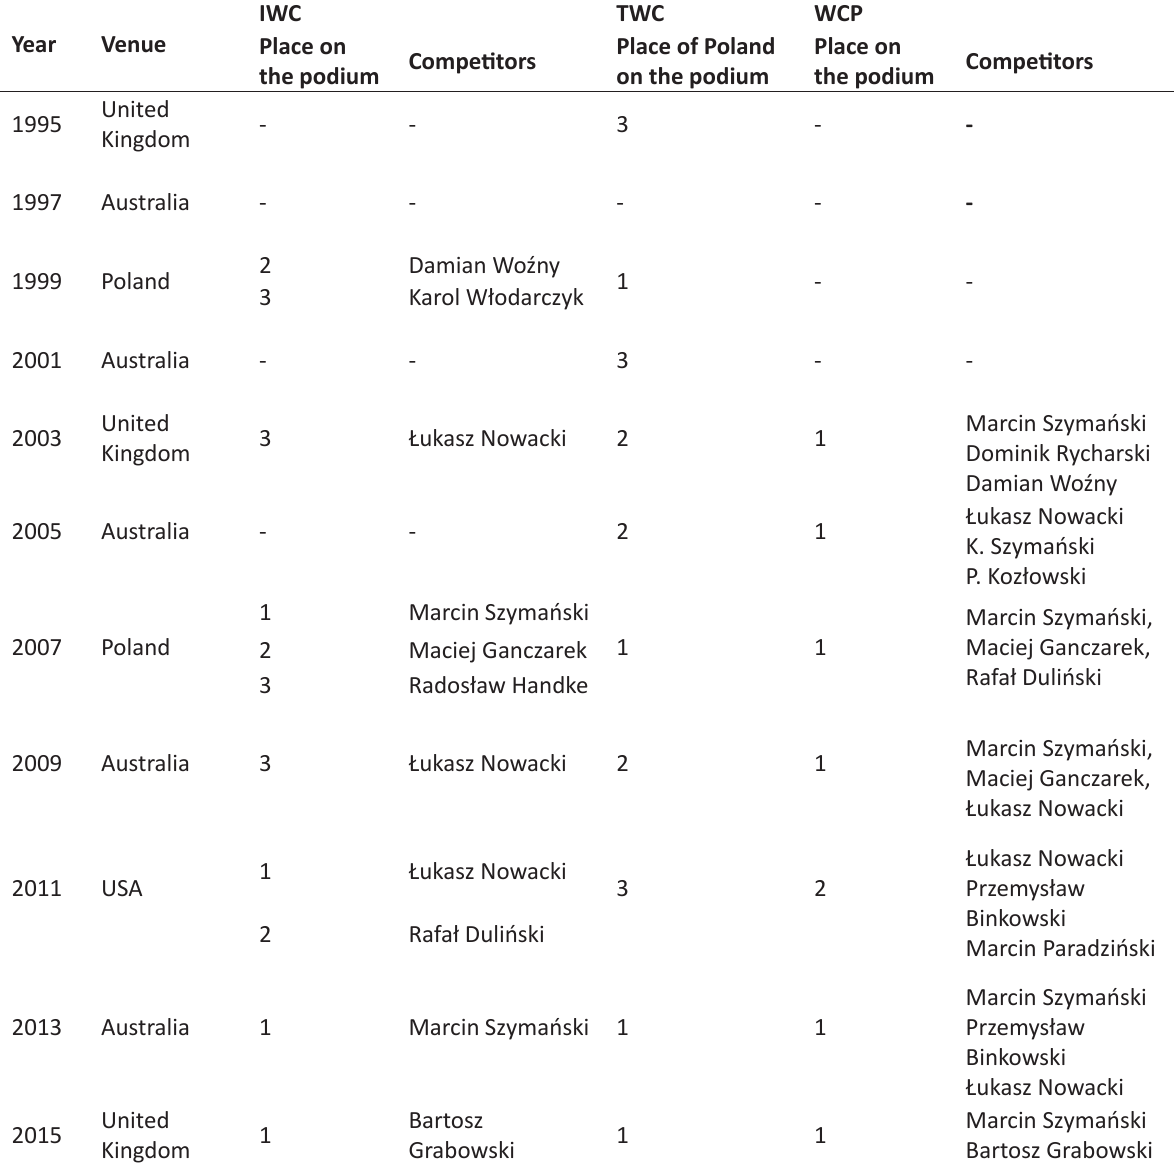
Table 1. Successes of Poles at Individual World Championships (IWC), Team World Championships (TWC) and World Championships of Pairs (WCP) in the years